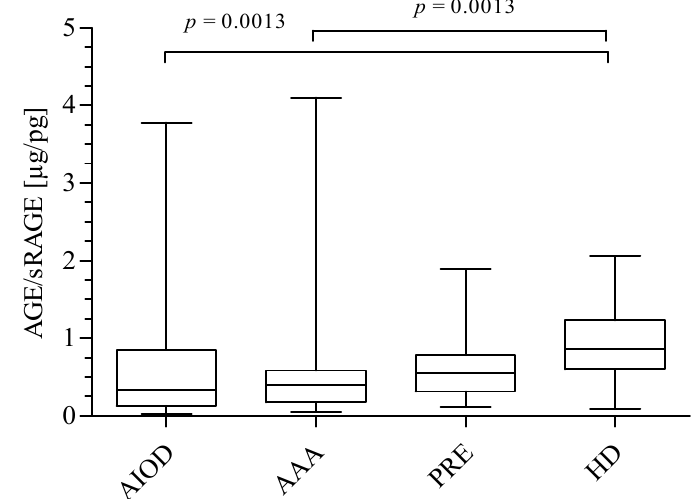
Figure 3. AGEs / sRAGE ratio in studied groups expressed as µ g / pg. The comparison of four studied groups was performed using the Kruskal–Wallis test followed by Dunn's multiple comparison test.